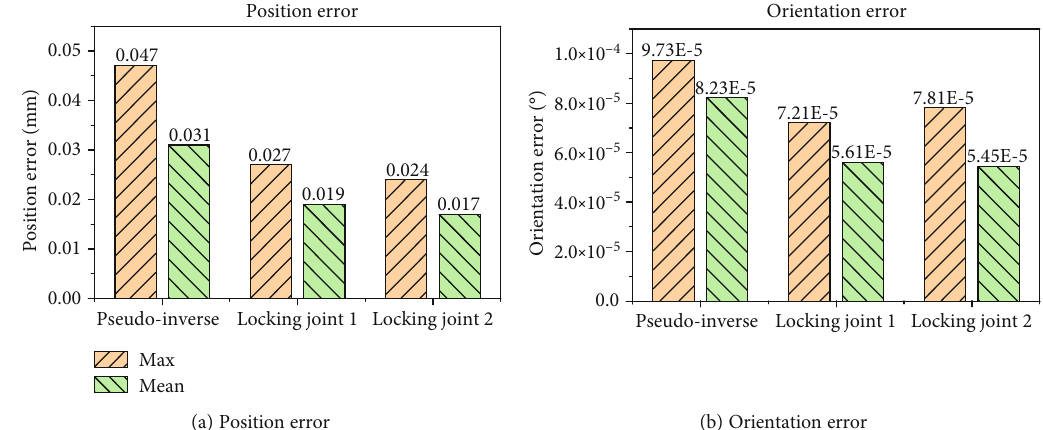
Figure 11: The mean position and orientation errors in the motion planning cases.